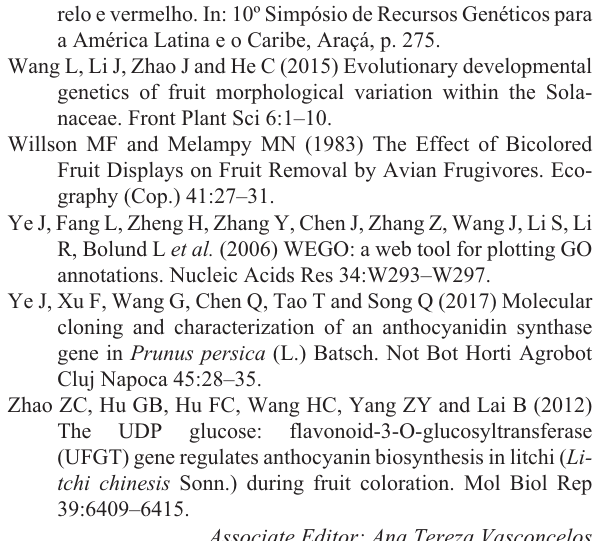
Table S1 - Statistical summary of sequences of Psidium cattleyanum libraries obtained for yellow and red morpho- types Table S2 - Total differential gene expression among P. cattleyanum yellow and red morphotype. Table S3 - Top 100 differential gene expression between Leaf vs Ripe fruit in red morphotype. Table S4 - Top 100 differential gene expression between Un- ripe vs Ripe fruit in yellow morphotype. Table S5 - Top 100 differential gene expression between Un- ripe vs Ripe fruit in red morphotype. Table S6 - Species information used to perform